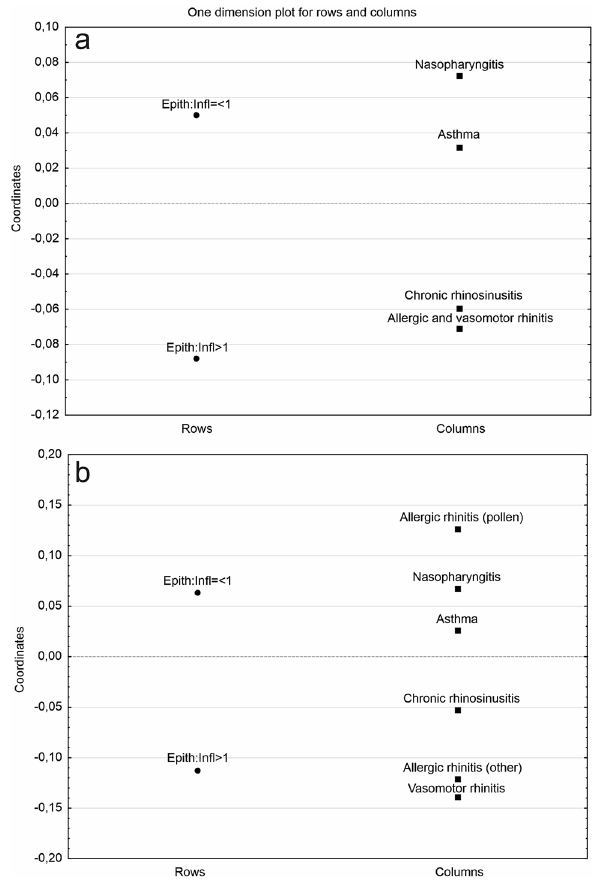
Figure 1. The intensity of nasal inflammation in relation to the primary ( a ) and the more detailed disease entities diagnosis ( b